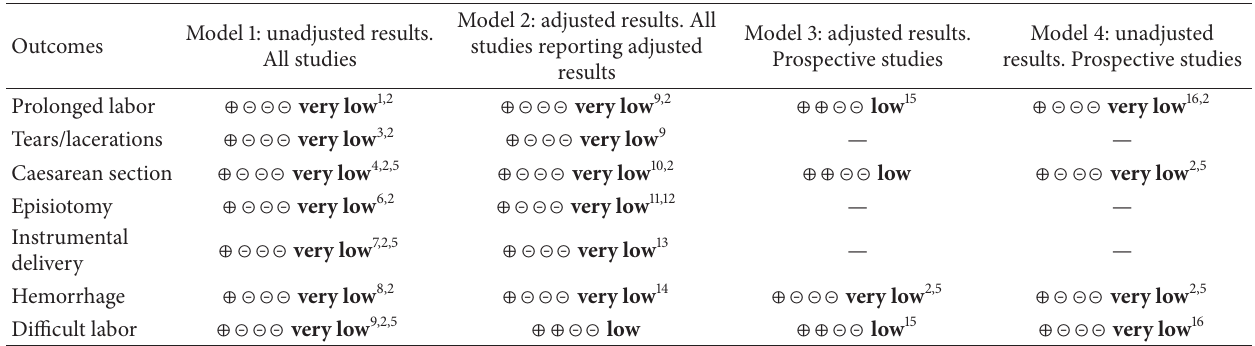
Table 2: Summary of GRADE